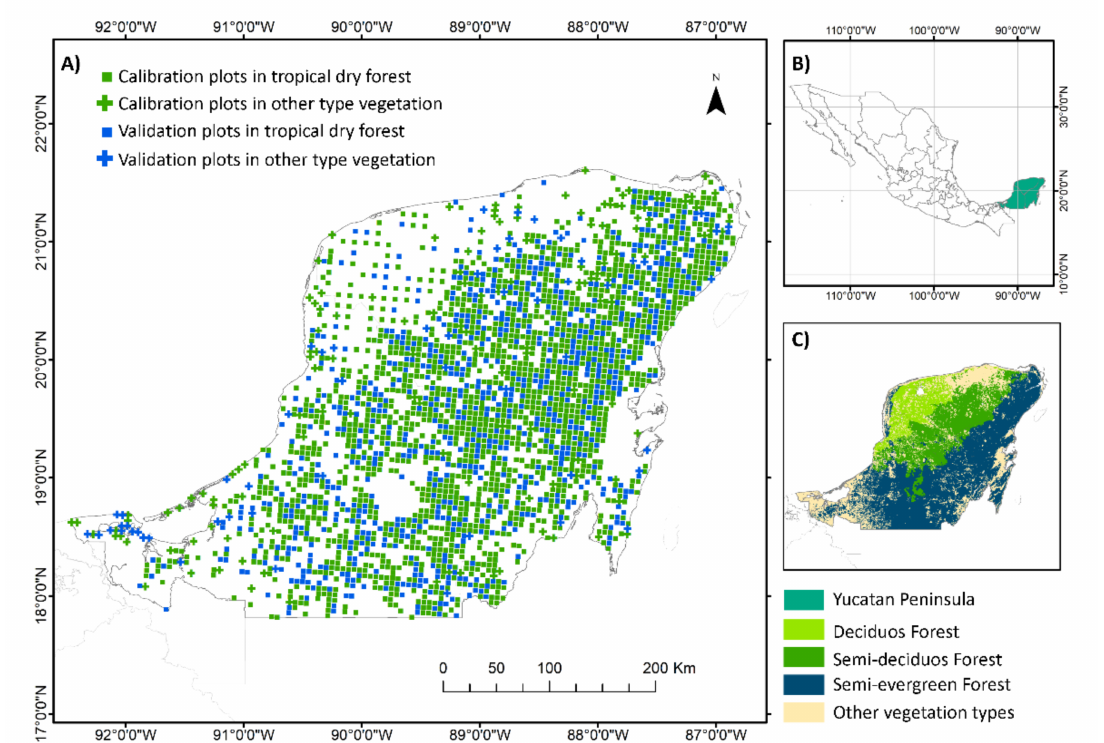
Figure 1. Location of the study area and field plots distribution: ( A ) the spatial distribution National Forest Inventory (NFI) field plots in the study area, ( B ) location of the Yucatan Peninsula, ( C ) distribution of the main vegetation types in the